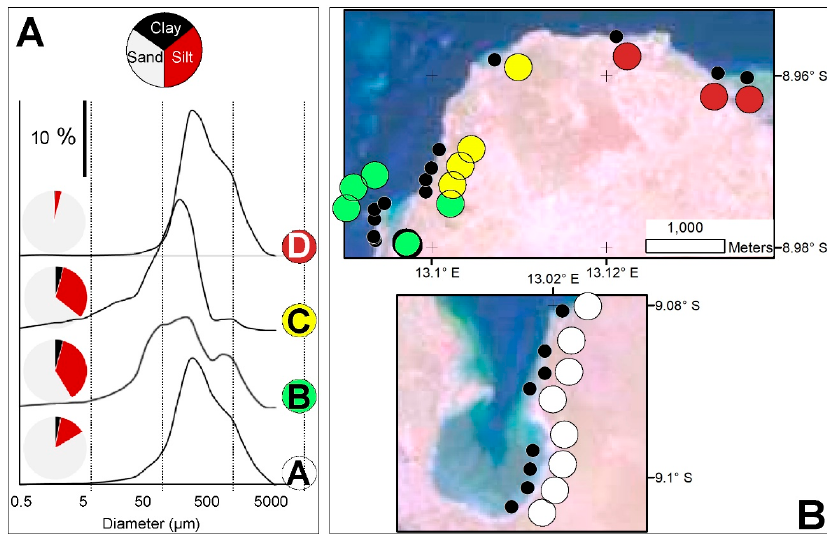
Figure 2. Grain-size of the Mussulo lagoon sediments. General features of different grain-size types (A) and their spatial distribution (B).